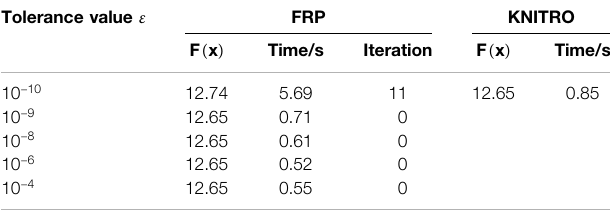
TABLE 6 | Comparison of FRP and